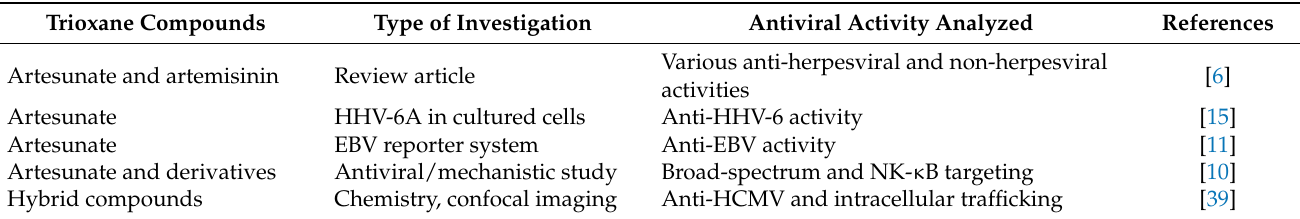
Table 1. Broad-spectrum antiviral activity of ART and ART-derived compounds including the highly active trimeric derivative